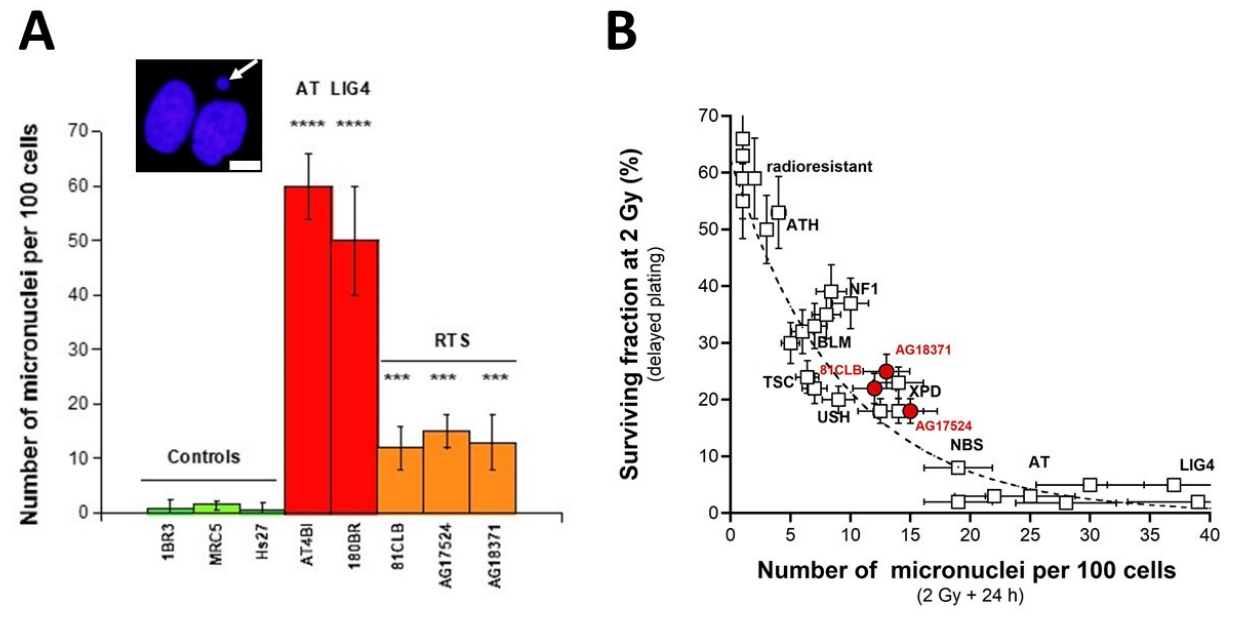
Figure 2. Micronuclei in RTS fibroblasts. ( A ). Number of micronuclei per 100 cells assessed 24 h after 2 Gy X-rays in the radioresistant controls (1BR3, MRC5, Hs27), the hyper-radiosensitive ATM - (AT4BI) and LIG4 - (180BR) mutated, and the three RTS (81CLB, AG17524, AG18371) fibroblast cell lines. Each plot represents the mean ± SEM of three replicates. The insert shows a representative example of a micronucleus (white arrow) observed with DAPI counterstaining. The white bar corresponds to 5 µ m. Asterisks represent statistical differences with radioresistant controls expressed as the p -value (3 and 4 asterisks correspond to p < 0.001 and p < 0.0001, respectively). AT: ataxia telangiectasia; LIG4: LIG4 syndrome. ( B ). With the use of historical data published in [45], the SF2 data and the corresponding micronuclei data from fibroblasts derived from the indicated syndromes (open squares) were plotted together (AT: ataxia telangiectasia, homozygous mutations of ATM ; LIG4: homozygous mutations of LIG4 ; NBS: Nijmegen’s syndrome, homozygous mutations of NBS1 ; XPD: xeroderma pigmentosum D, homozygous mutations of XPD ; USH, Usher’s syndrome, homozygous mutations of USH; TSC, tuberous sclerosis, heterozygous mutation of TSC ; Bloom’s syndrome, homozygous mutations of BLM ; NF1, neurofibromatosis type 1, heterozygous mutations of neurofibromin; ATH, heterozygous mutations of ATM) . The survival and micronuclei data from the RTS fibroblast cell lines shown in Figures 1 and 2A were added to the graph (red circles). The best data fit was obtained with a linear equation: SF2(%) = 62.2 exp( − 0.107 MN 24h ); r 2 = 0.939 (dotted line).